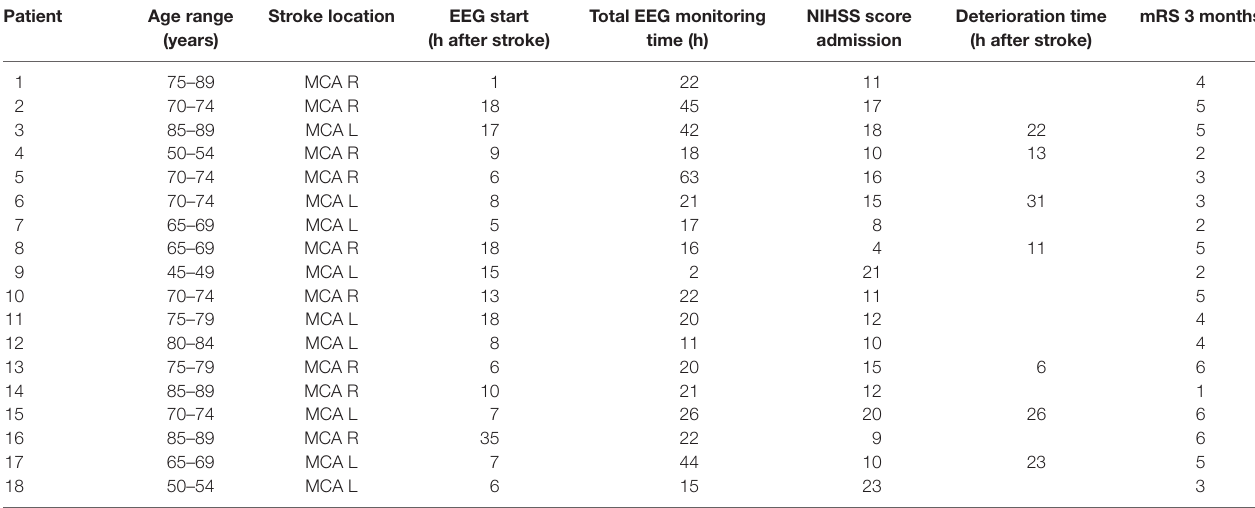
TaBle 1 | Baseline characteristics and outcome of patients with acute cortical ischemic stroke. Patient age range